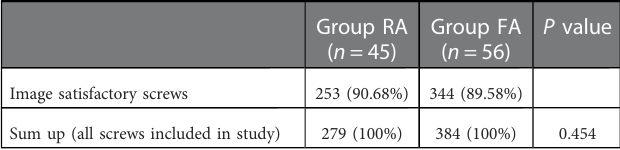
TABLE 2 Results of the radiological assessment of pedicle screw insertion between two